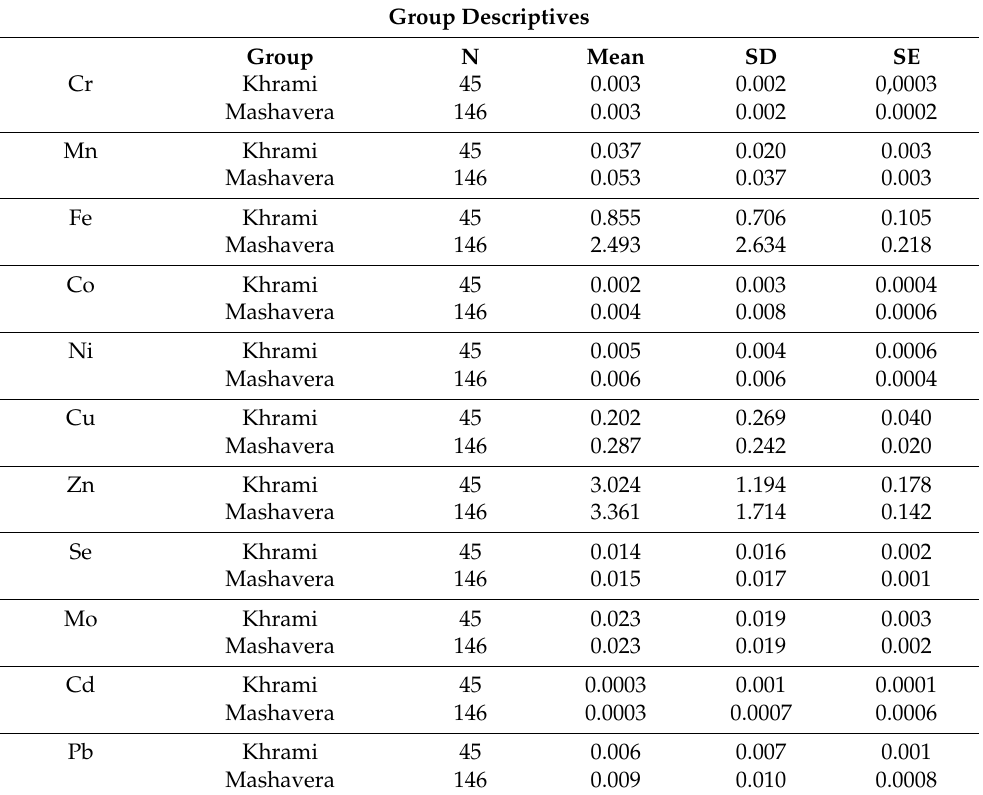
Table A2. Descriptive statistic of the trace elements in milk according to the rivers.